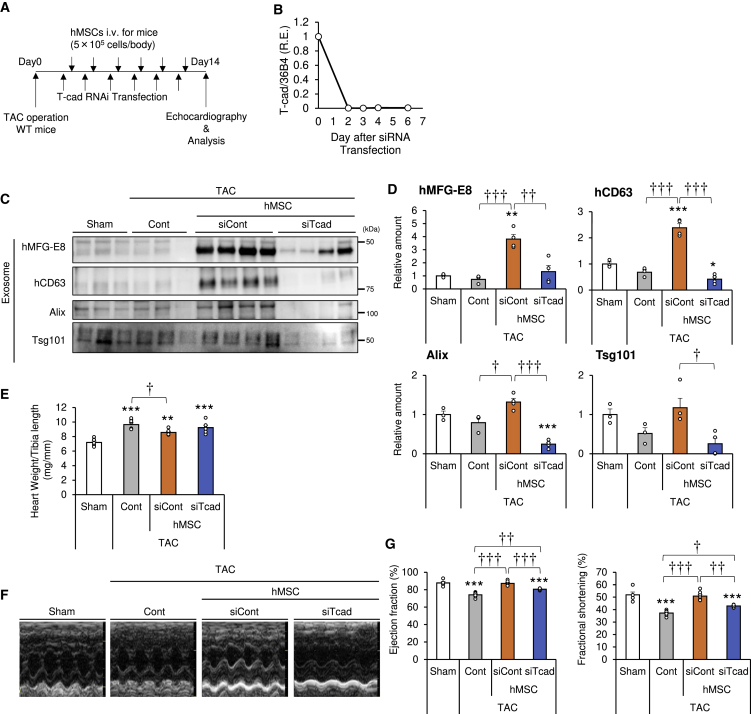
Importance of T-cadherin in hMSCs for Adiponectin-Induced Exosome Production and Cardioprotection In Vivo(A) Experimental design for intravenous injection of hMSCs in the transverse aortic constriction (TAC) model. hMSCs were transfected with control or T-cad (CDH13) RNAi and injected at a concentration of 5.0 × 105 cells per body via the tail vein the day after transfection. Injections were repeated six times at 2- to 3-day intervals within a period of 2 weeks. Echocardiography was performed at day 14. (B) Relative expression of T-cadherin in hMSCs after RNAi transfection at an indicated time points (n = 2). (C) Representative immunoblots. Serum exosomes were subjected to western blot analysis with the indicated antibodies to exosome markers. (D) Serum exosome marker levels from western blots (n = 3–4). (E) Heart weight per tibia length ratio (n = 6–8). (F) Representative images of echocardiography. (G) Ejection fraction (EF) and fractional shortening (FS) at 2 weeks after TAC or sham surgery (n = 6–8). Data are mean ± SEM. All subjects in this figure were tested in two separate trials. ∗p < 0.05; ∗∗p < 0.01; ∗∗∗p < 0.001 versus sham. †p < 0.05; ††p < 0.01; †††p < 0.001 between groups, by one-way analysis of variance with post hoc Tukey’s multiple comparisons.